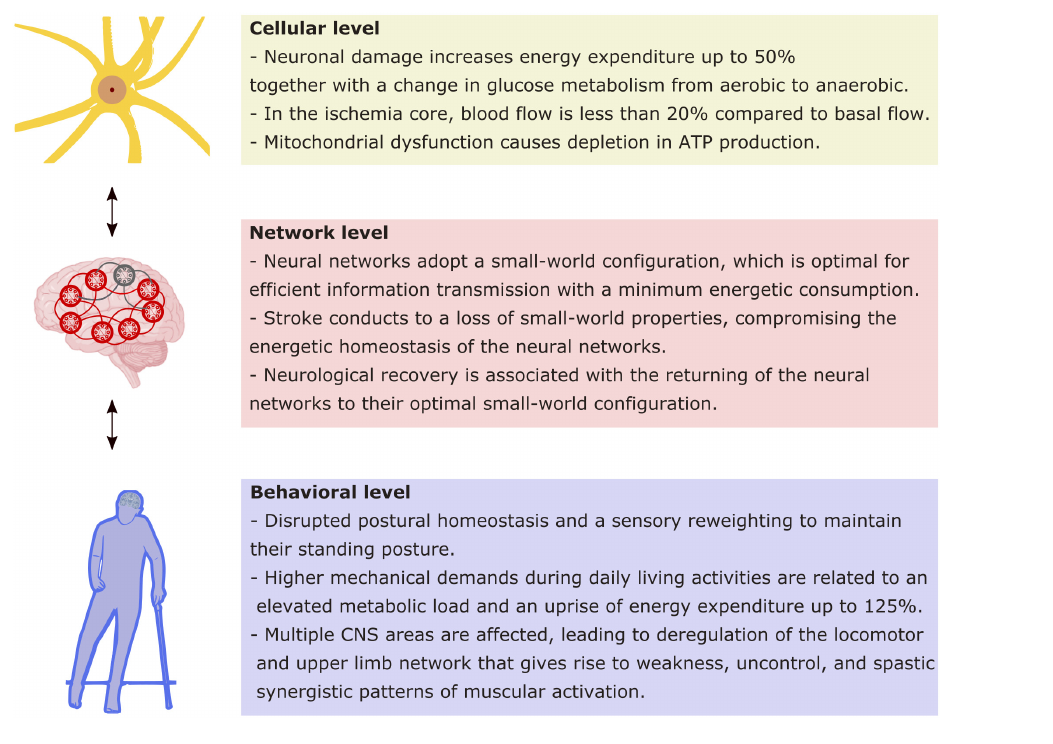
FIGURE 1 | Energy implications at different levels of functioning as a consequence of stroke. Schematic synthesis of the main implications of stroke in energetic functioning at the cellular, network, and behavioral levels. Every level impacts reciprocally in the following, as indicated by bidirectional